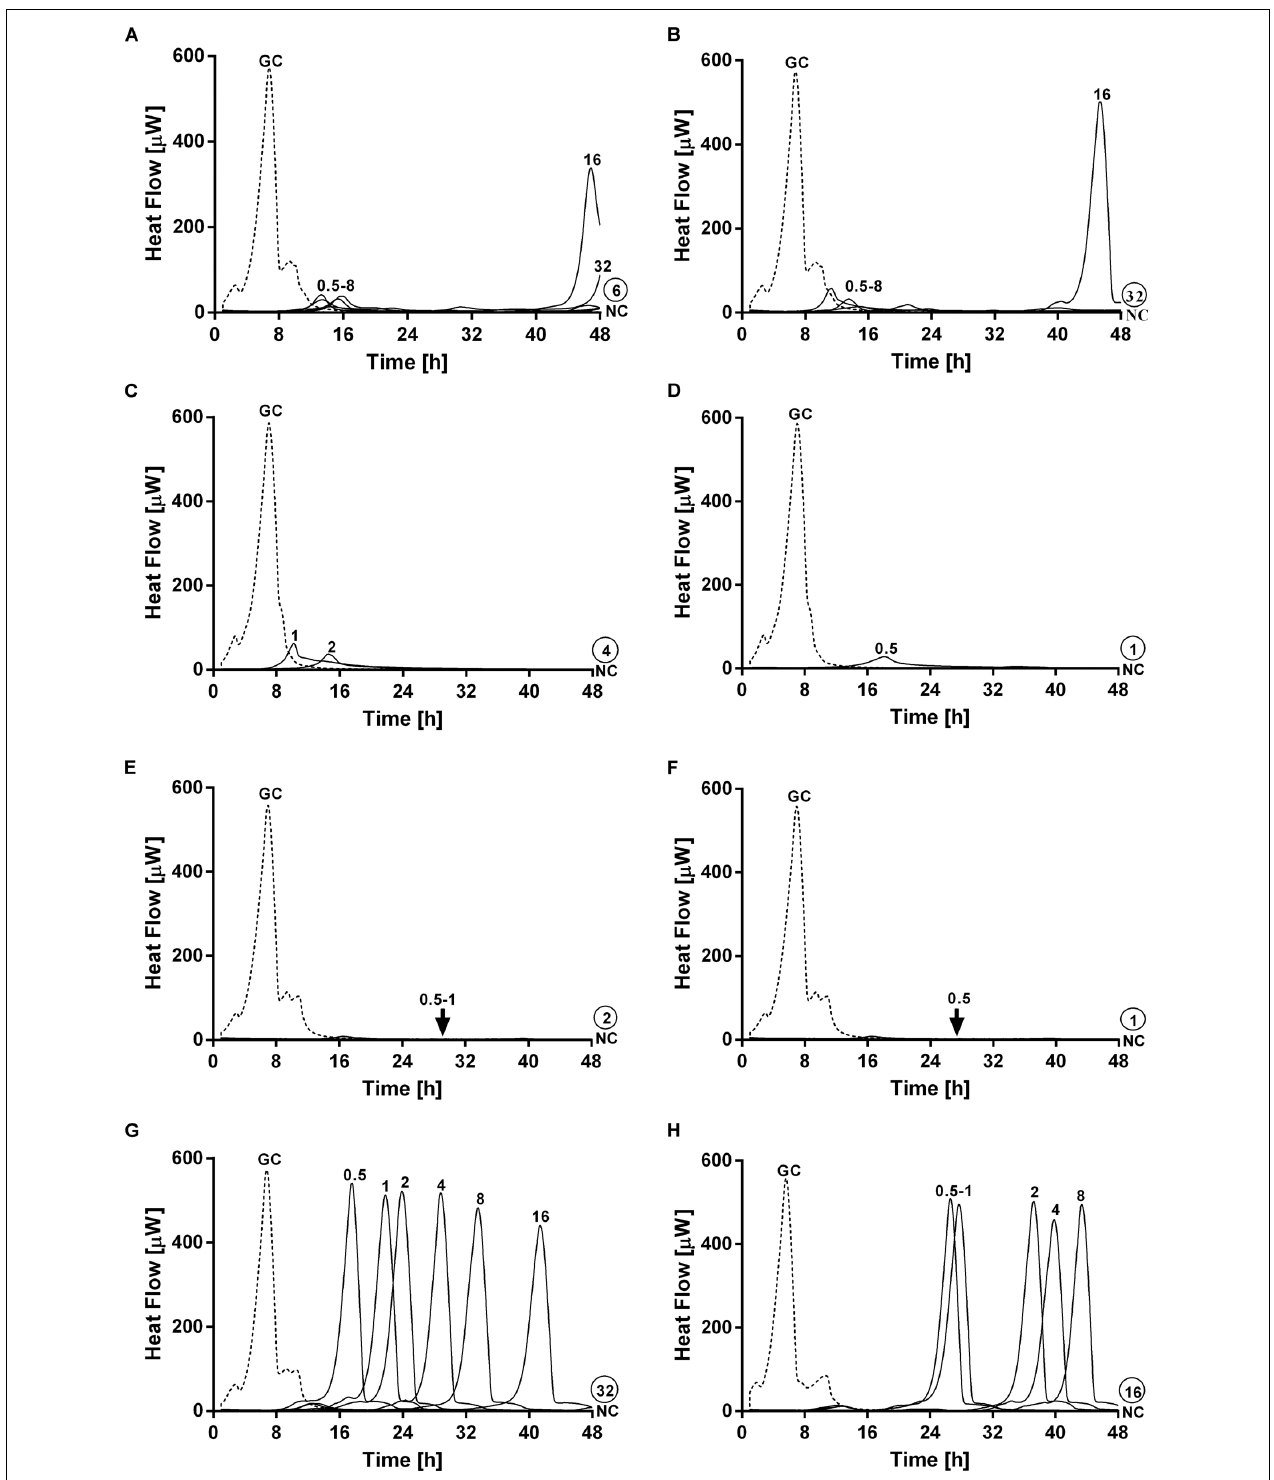
FIGURE 7 | Evaluation of MRSA ATCC 43300/ P. aeruginosa ATCC 27853 dual-species biofilm viability after staggered exposure to phages and ciprofloxacin monitored by microcalorimetry. Each curve shows the heat produced by viable bacteria present in biofilms pretreated for 3 h (A,B) , 6 h (C,D) , 12 h (E,F) and 24 h (G,H) with PYO (graphs on the left) or PYO+Sb-1 (graphs on the right) followed by exposure to ciprofloxacin at increasing doses (0.5–64 mg/L) for 24 h. Numbers above curves represent antibiotic concentrations (in mg/L). Circled values represents the MBEC, defined as the lowest concentration of antibiotic that strongly reduced the viability of biofilm cells leading to the absence of heat flow production from treated beads when incubated during 48 h in fresh medium and no colonies after sonication and plating. GC, growth control (dashed line); NC, negative control.